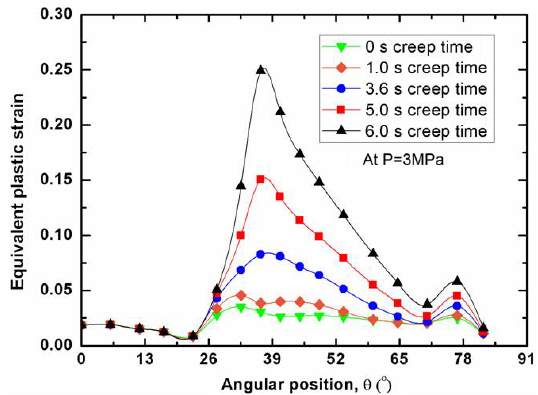
Figure 9. Effect of creep on plastic strain distribution for RPV with low water